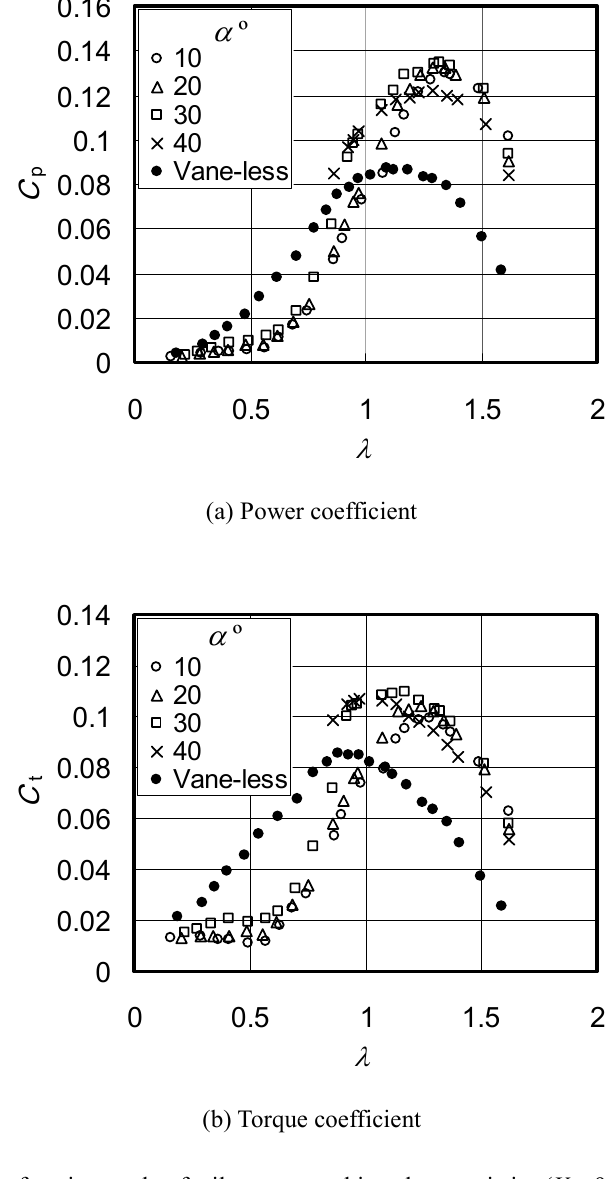
Effect of setting angle of tail vane on turbine characteristics ( V = 9.0m/s, σ =